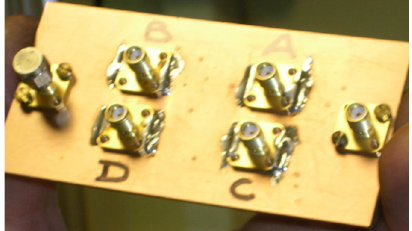
FIG. 20. (Color) The fake block simulates a BPM block re- sponse to a centered beam. The fake block is driven by a rf generator to allow cable and electronics calibration after instal- lation in site without the beam.